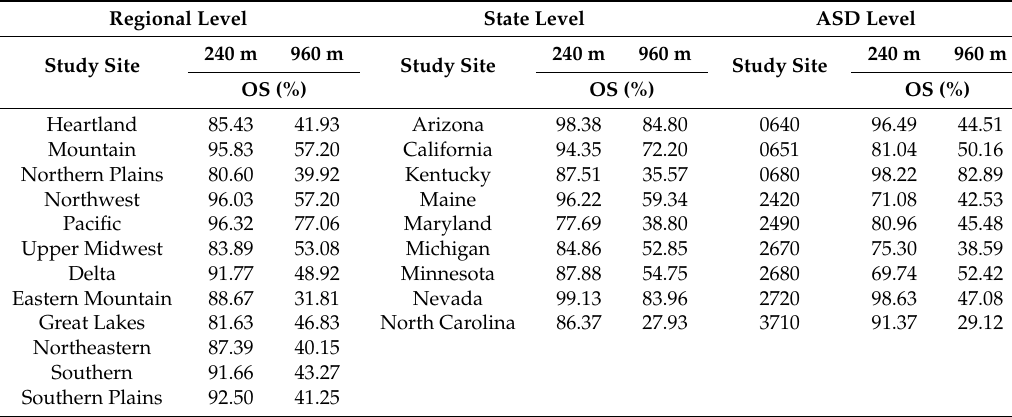
Table 7. The Overall Similarity (OS) of the Global Food Security-Support Analysis Data (GFSAD) maps for each study site.